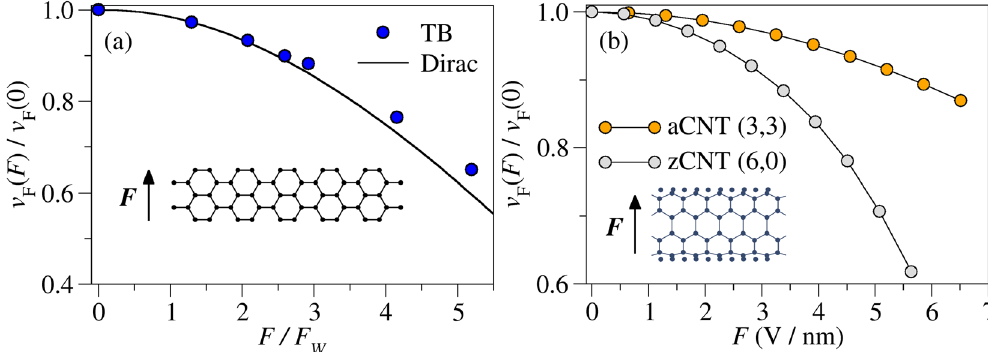
Figure 3. ( a ) Fermi velocity for a metallic aGNR as a function of the normalized field F / F W (see main text for details). A prominent agreement between the TB approach and the Dirac equation is observed. ( b ) Fermi velocity for a metallic aCNT and a zCNT as a function of the field F = Δ V / d , where Δ V is the potential drop across the CNT and d is its diameter. v F ( F = 0) = 8.617 × 10 5 m/s for the zCNT and v F ( F = 0) = 8.010 × 10 5 m/s for the aCNT. In all cases, v F is significantly reduced when the field is switched